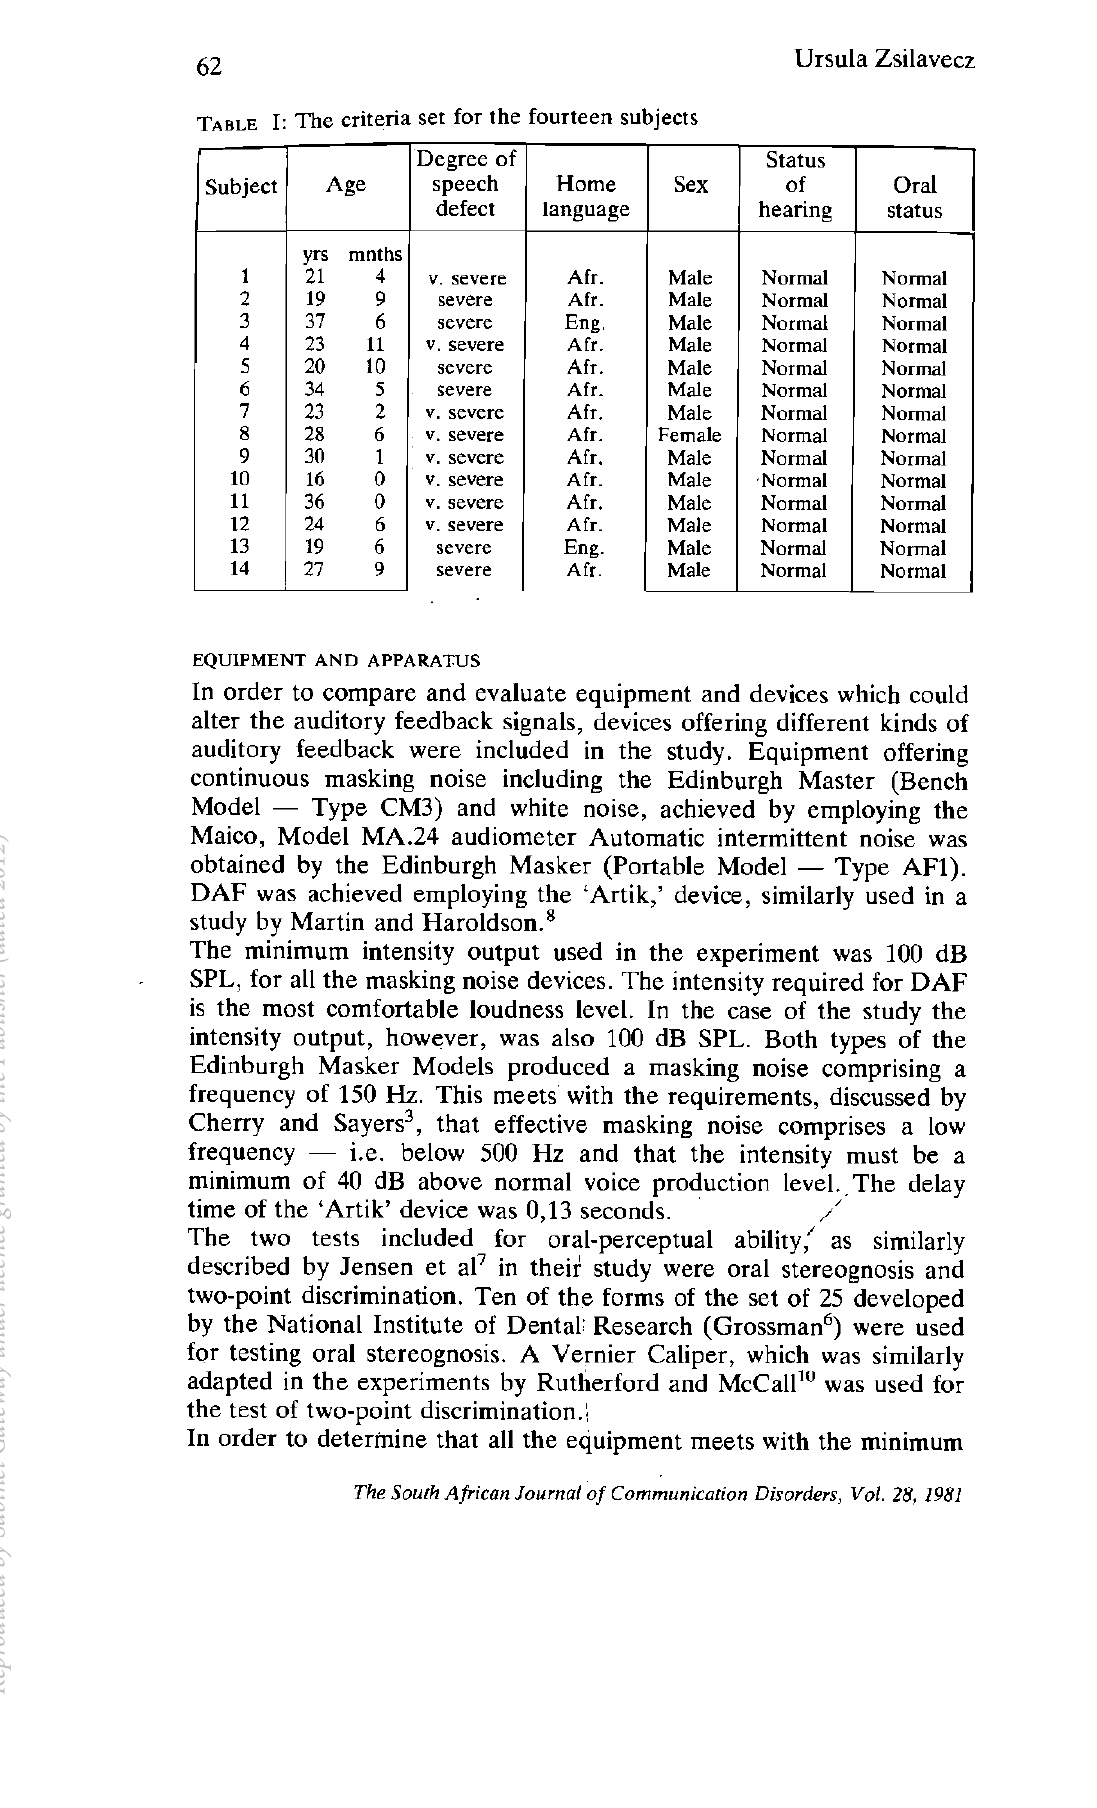
TABLE I: The criteria set for the fourteen